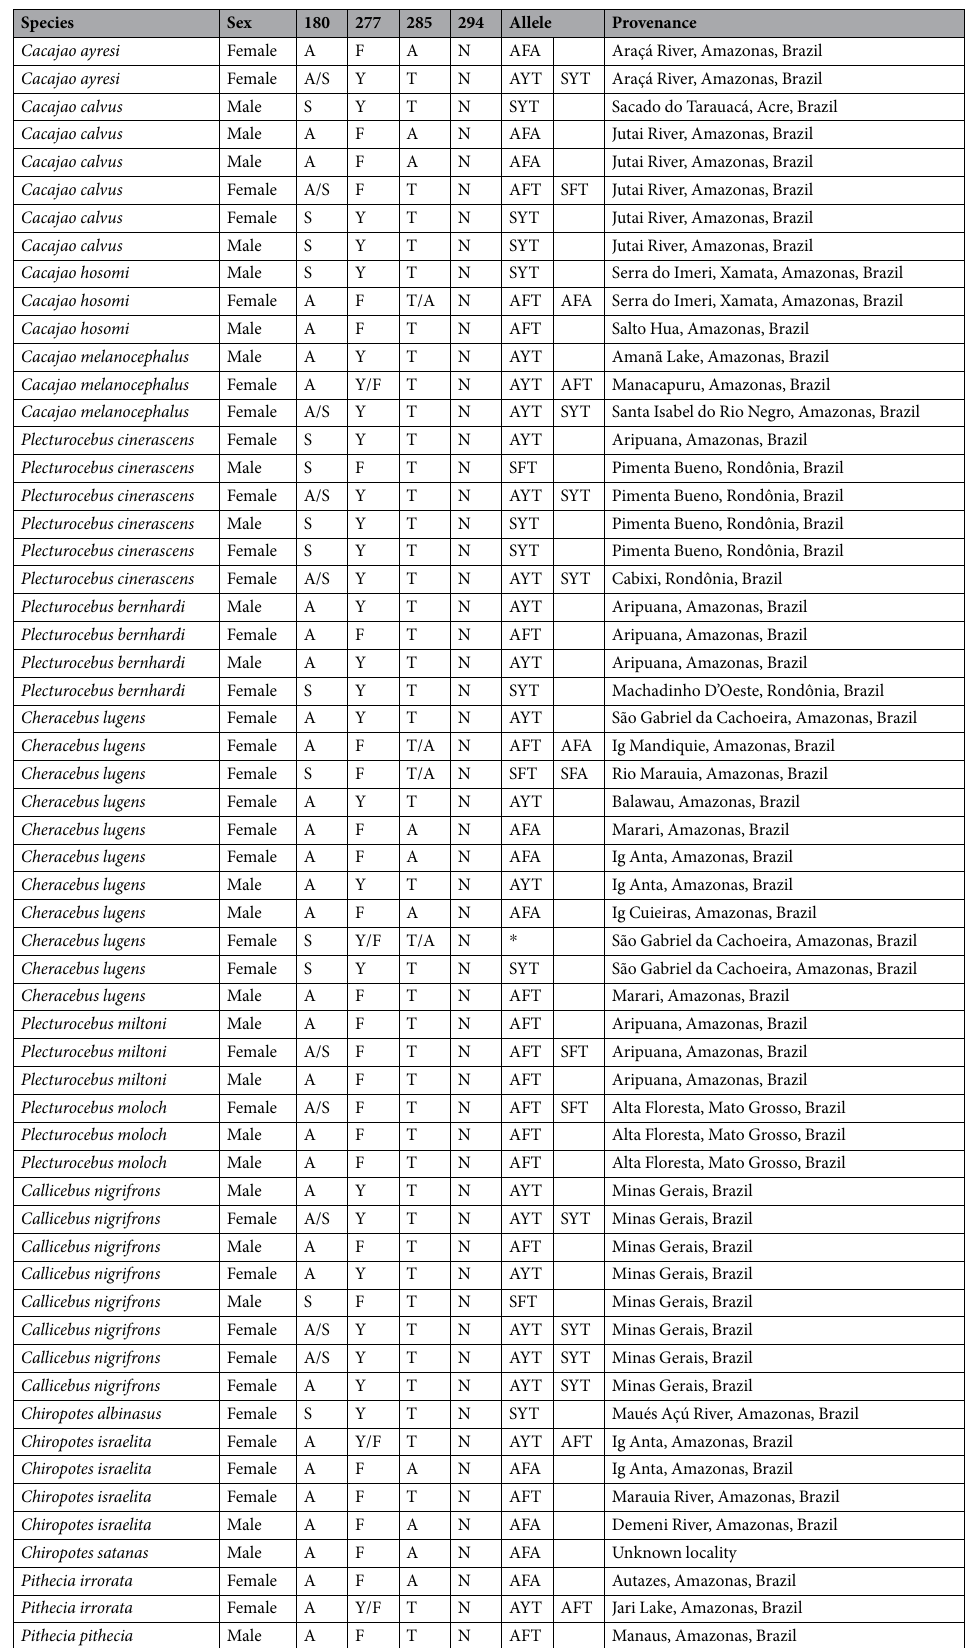
Table 2. List of species and medium/long wavelength sensitive genotypes found in